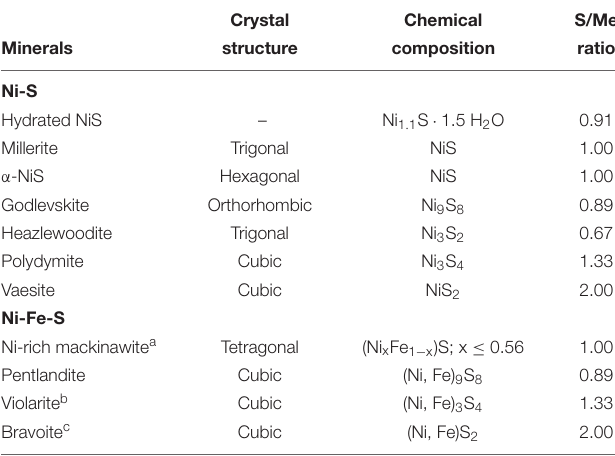
TABLE 1 | Crystal chemistry for Ni-sulfide and Ni-Fe-sulfide